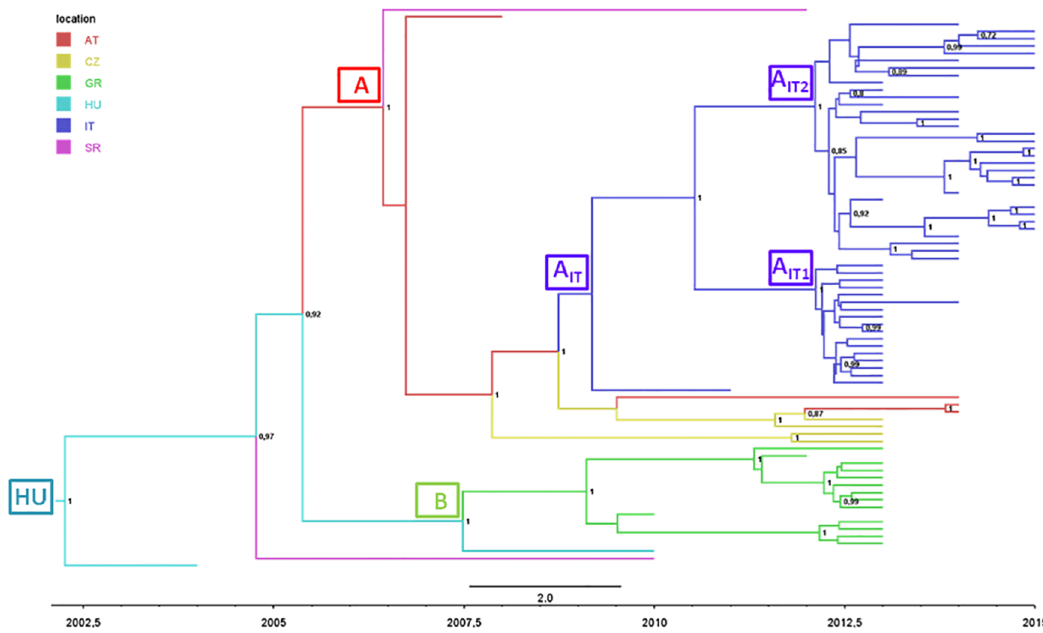
Fig 2. Phylogeographic analysis of 77 European WNV-2 isolates forming a single monophyletic group. The branches of the maximum clade credibility(MCC) tree are coloured on the basis of the most probablelocation of the descendent nodes(AT = Austria; CZ = Czech Republic;GR = Greece; HU = Hungary;IT = Italy; SR = Serbia). The numbers on the internalnodesindicate significantposterior probabilities (pp > 0.7), and the scale at the bottom of the tree represents calendar years. The main geographicalclades are highlighted.